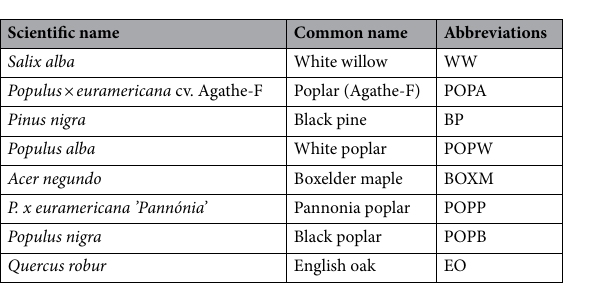
Table 2. Scientific name, common name and abbreviation of eight tree species (cultivars) assessed in the study area (Gemenc, Hungary,